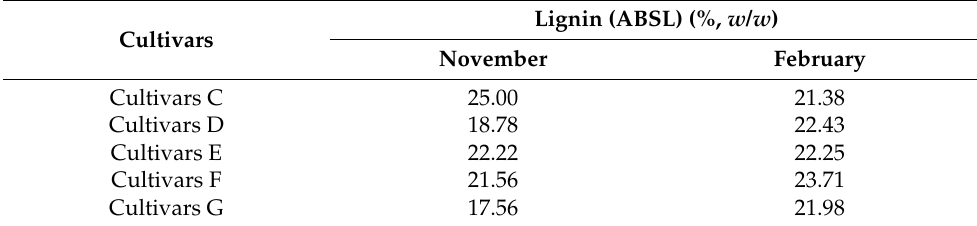
Table 3. Lignin content of Miscanthus Cultivars C–G.